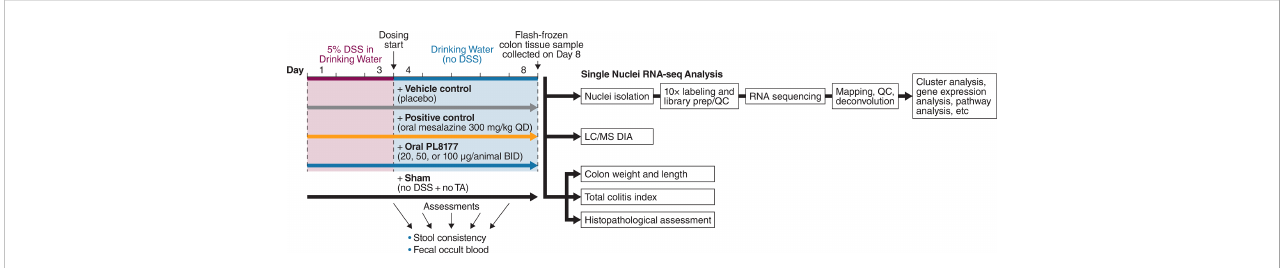
FIGURE 1 Design of the DSS-induced rat colitis study. BID, twice daily; DSS, dextran sulfate sodium, LC/MS DIA, data-independent acquisition tandem mass spectrometry QC, quality control; QD, once daily; RNA-seq, RNA sequencing; TA, test